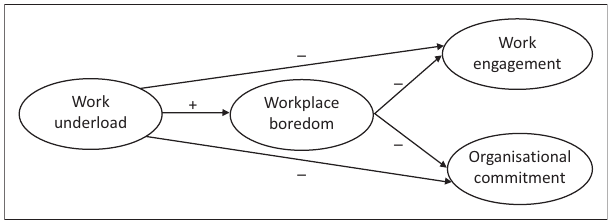
FIGURE 1: The structural model for determining direct and indirect (mediated)